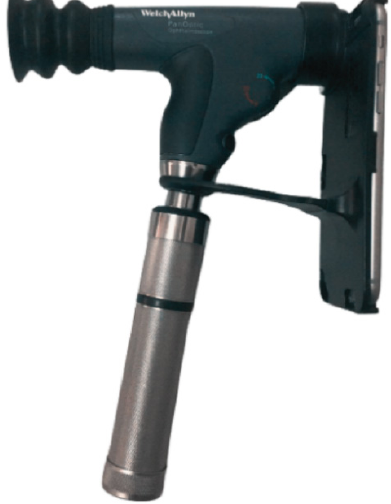
Figure 2. Panoptic ophthalmoscope Welch Allyn 11820.